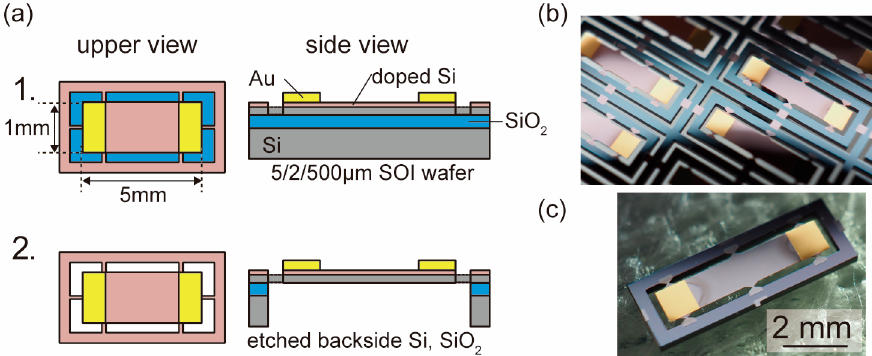
Figure 3. ( a ) Fabrication of ultrathin piezoresistive Si chip. 5- μ m-thick ultrathin piezoresistive Si chip was fabricated from the device layer of 5/2/500 μ m silicon on insulator (SOI) wafer. ( b ) A fabricated chip on the wafer. ( c ) Ultrathin Si chip was supported by six